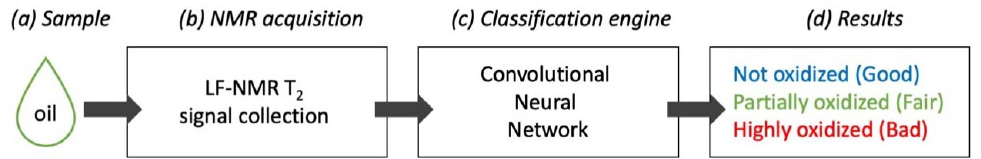
Figure 7. System setup—a typical workflow where a drop of oil is scanned with a low-field nuclear magnetic resonance (LF-NMR) machine; in the next step, the convolutional neural network (CNN) uses the T 2 signal as an input and returns the oil oxidation class as output.